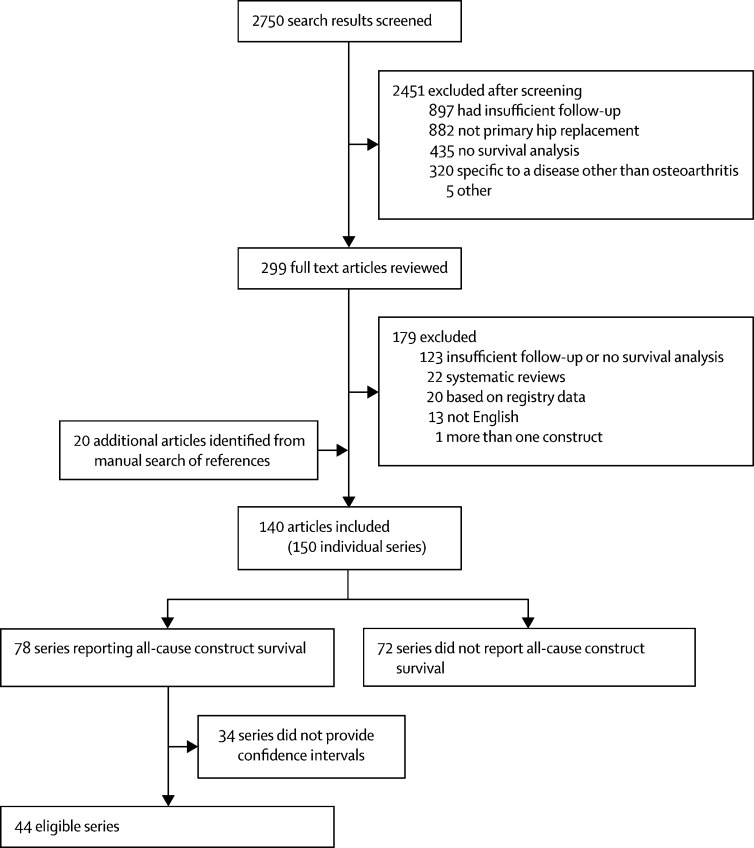
Article selection